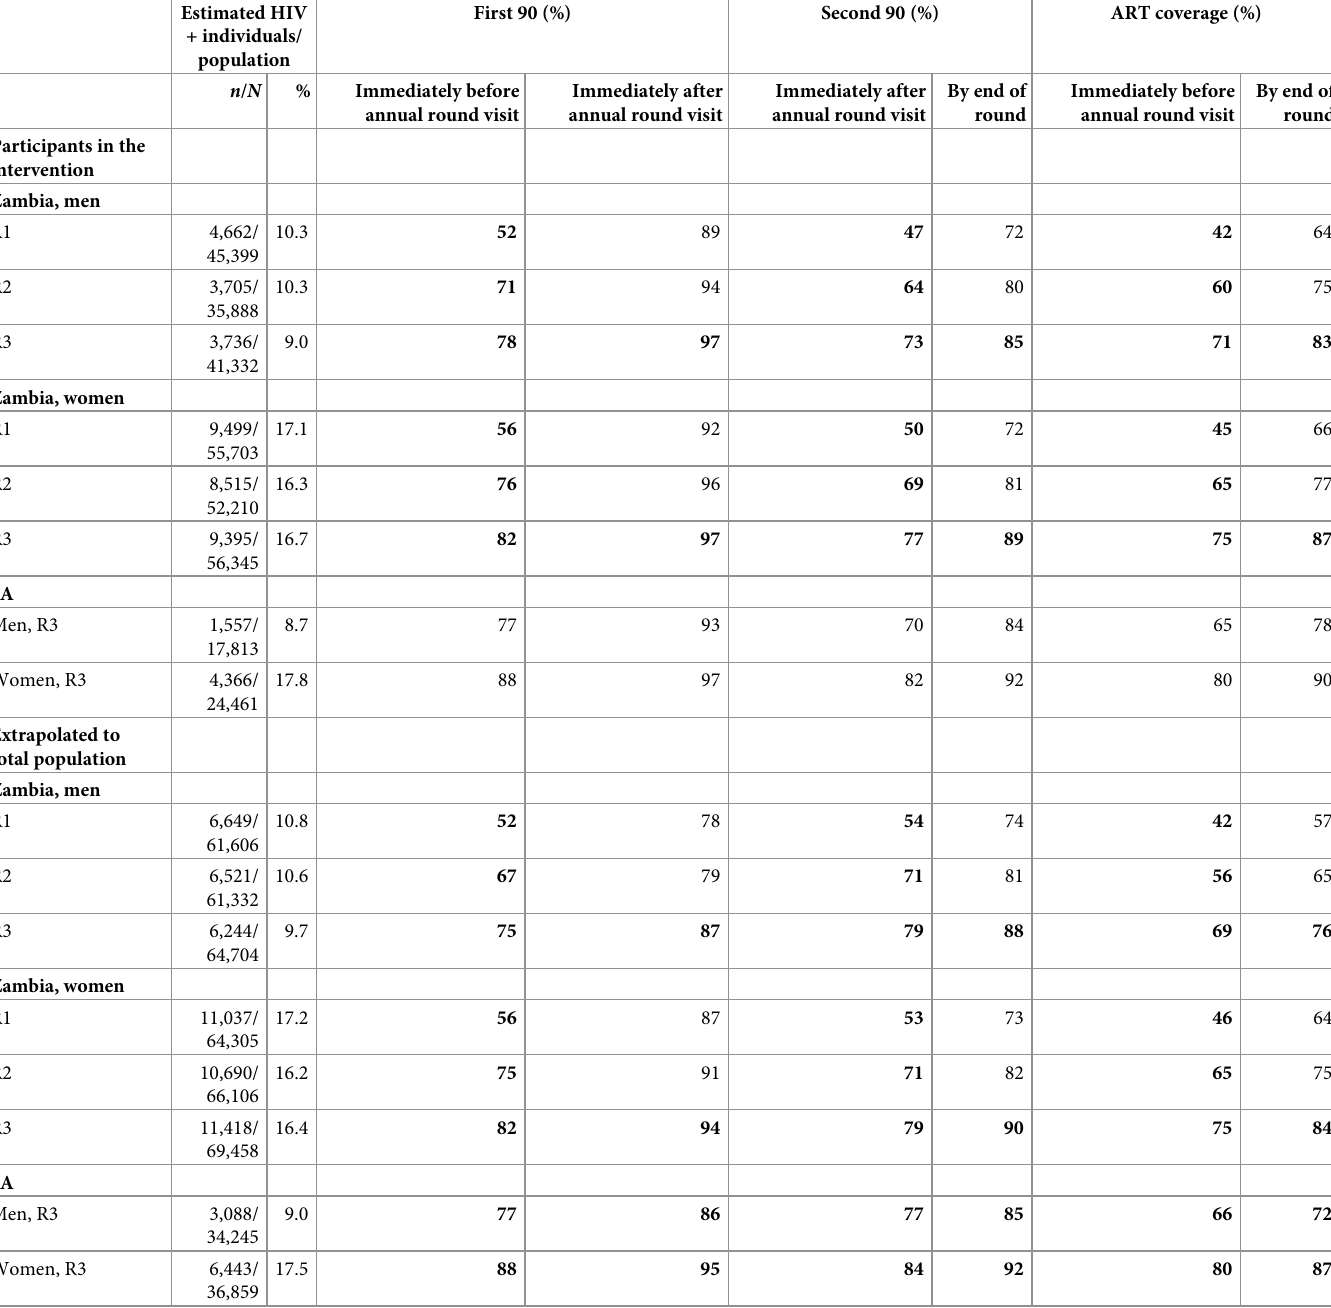
Table 2. Arm A: Estimates of the percentage of HIV-positive individuals who knew their HIV-positive status (first 90), the percentage on ART among individuals who knew their HIV-positive status (second 90), and the percentage on ART among all HIV-positive individuals (ART coverage). Estimated HIV +